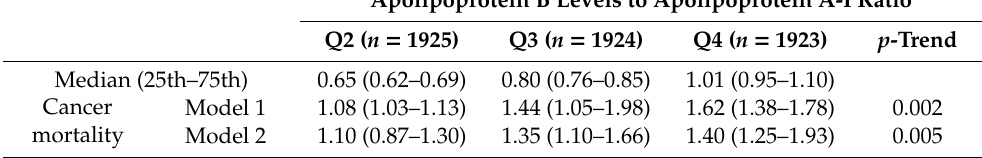
Table 2. Multivariable-adjusted hazard ratios (95% CI *) for cancer mortality across quartiles